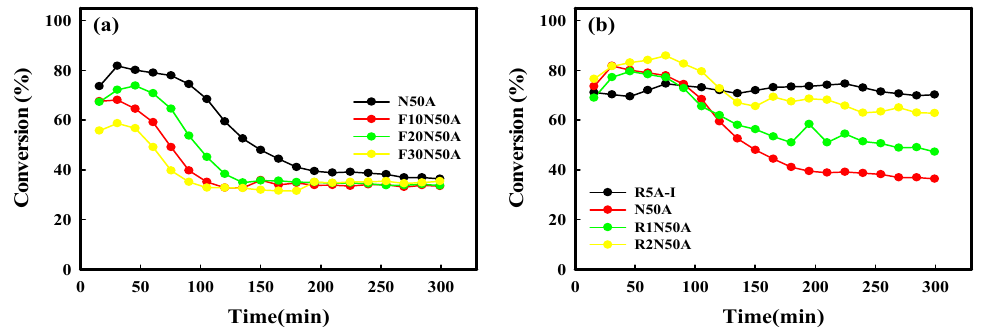
Figure 6. Conversions of the ( a ) N50A, F10N50A, F20N50A, and F30N50A and ( b ) R5A-I, N50A, R1N50A, and R2N50A of DHM fuel.